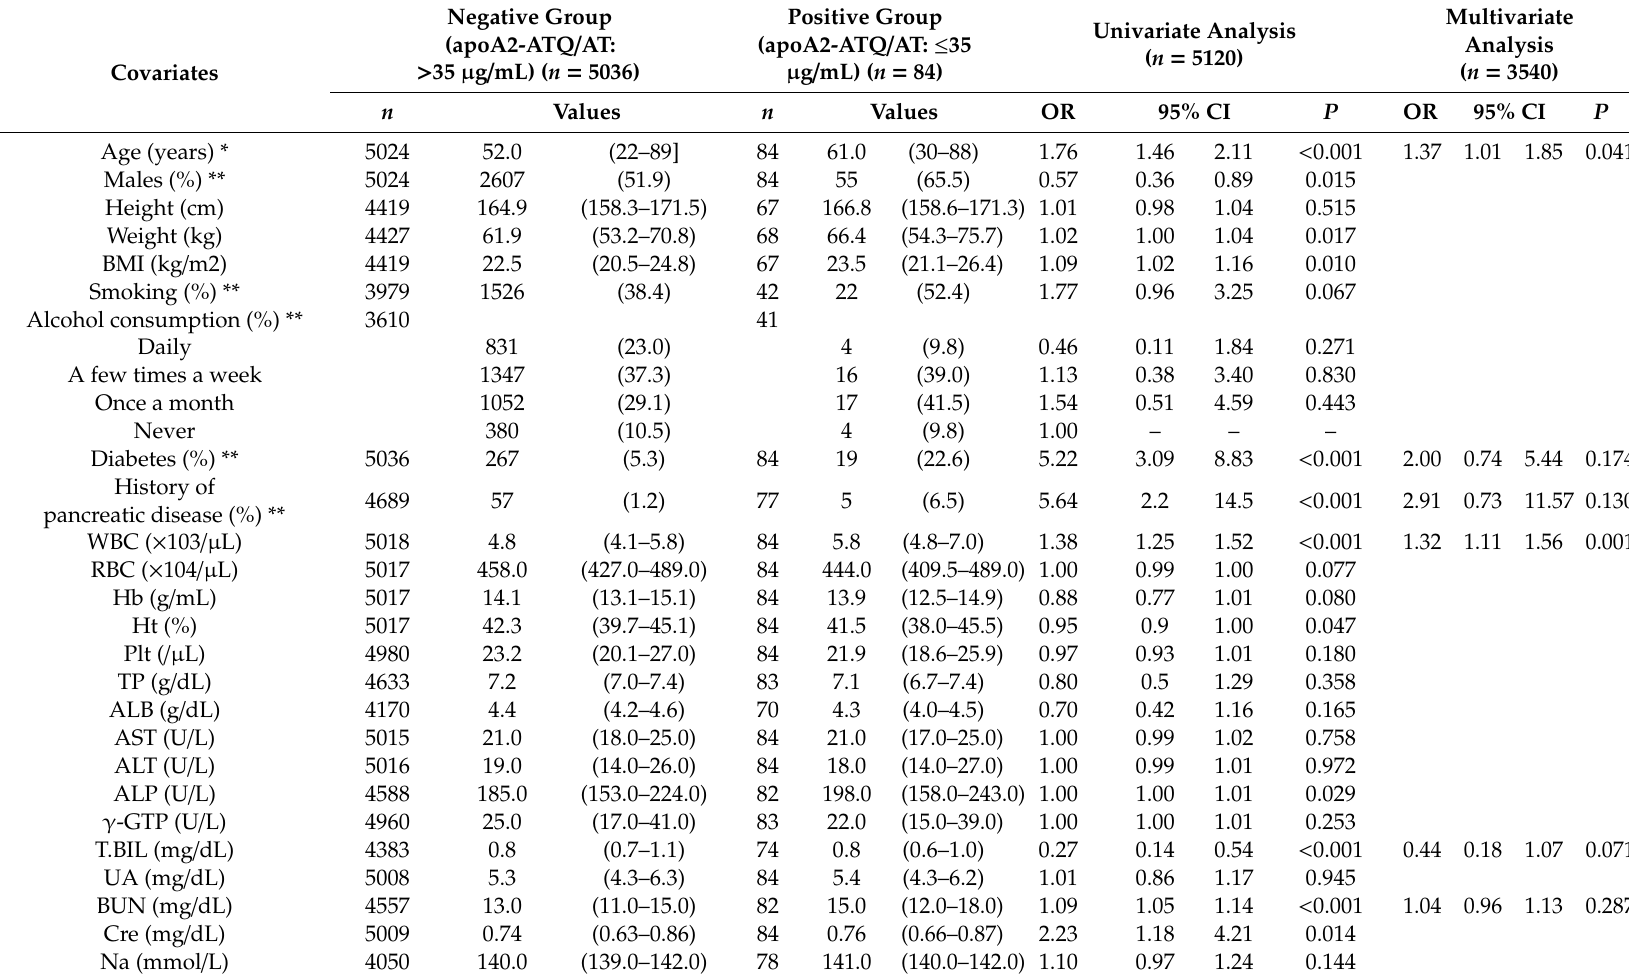
Table 2. Comparison of background characteristics between apoA2-ATQ / AT-positive and -negative groups in the screening study.